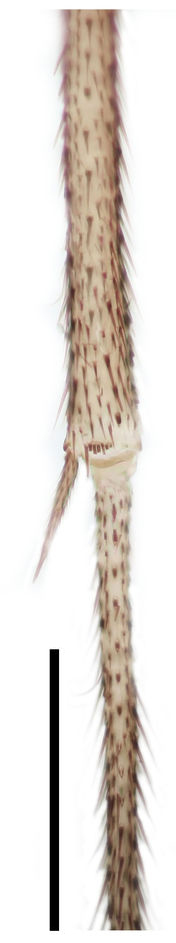
tip of fore tibia